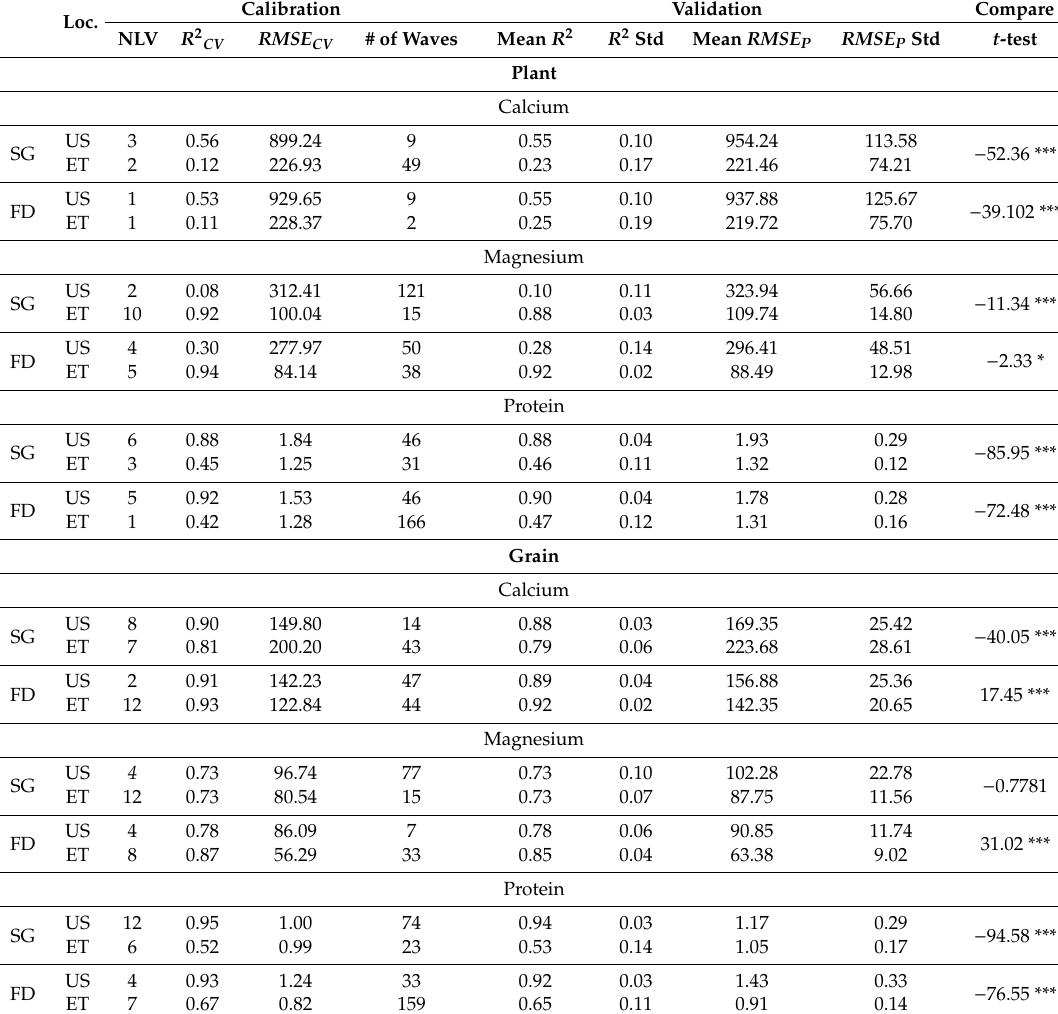
Table 4. Partial least squares (PLS) regression and t -test results for the waveband selection model (PLS-Wave) for plant and grain. SG: Savitsky–Golay; FD: First derivative; NLV: Number of latent variables; std: Standard